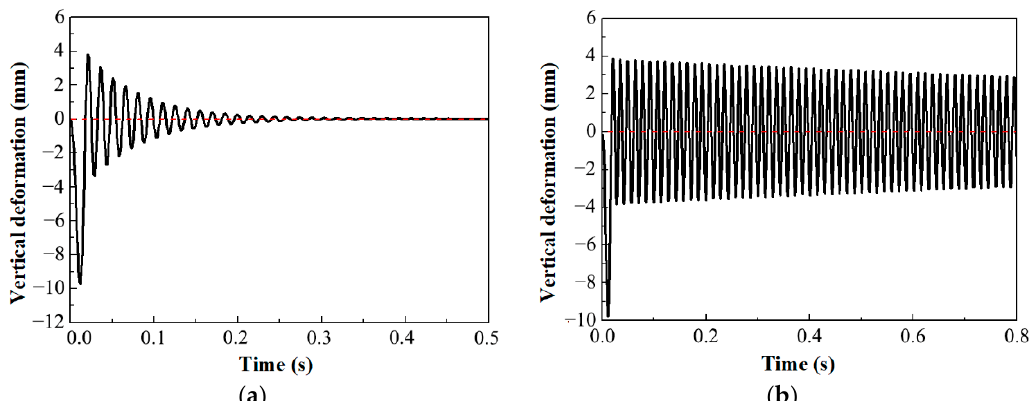
Figure 8. Pipe total deformation at 0.01 s with liquid hydrogen inside the pipe.